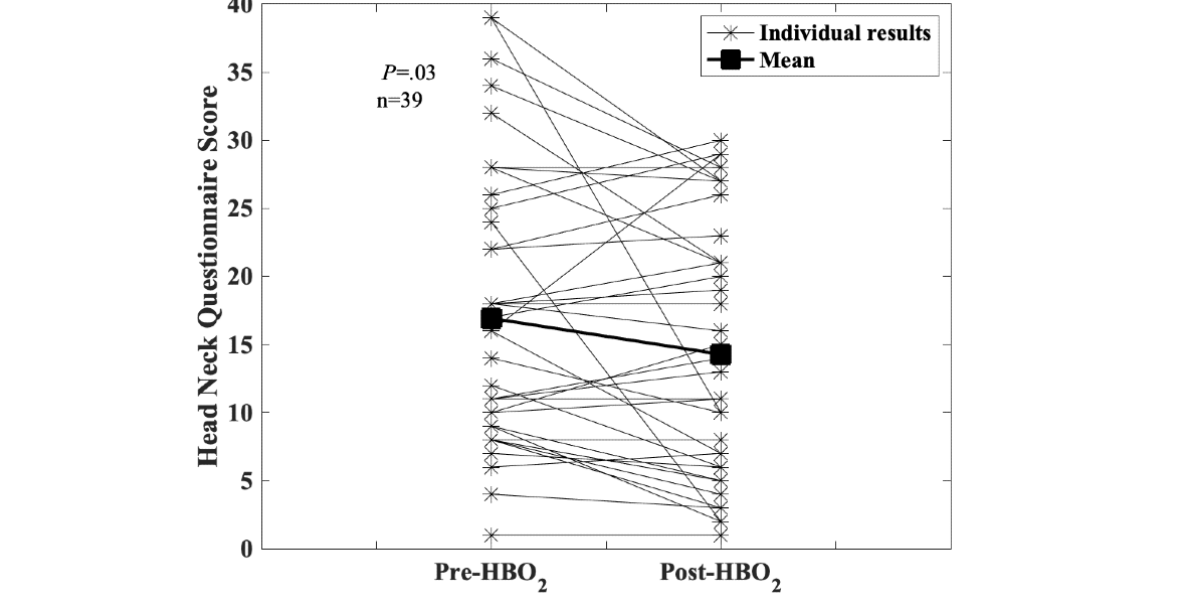
Figure 1. Delayed radiation injury. Scores on the Head and Neck Questionnaire before and after hyperbaric oxygen (HBO 2 ) are shown: lower scores indicate fewer symptoms. This questionnaire is administered to any patient who had experienced head and neck radiation and is being treated for radiation injury in the head and neck region. Although responses vary between patients, results show lower scores posttreatment (16.9 pretreatment to 14.3 posttreatment, P =.03, Wilcoxon signed-rank test). By identifying patients who did not respond or who worsened, these data can guide further analyses.